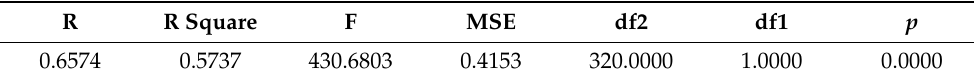
Table 6. Coefficients of Regression (path-a).